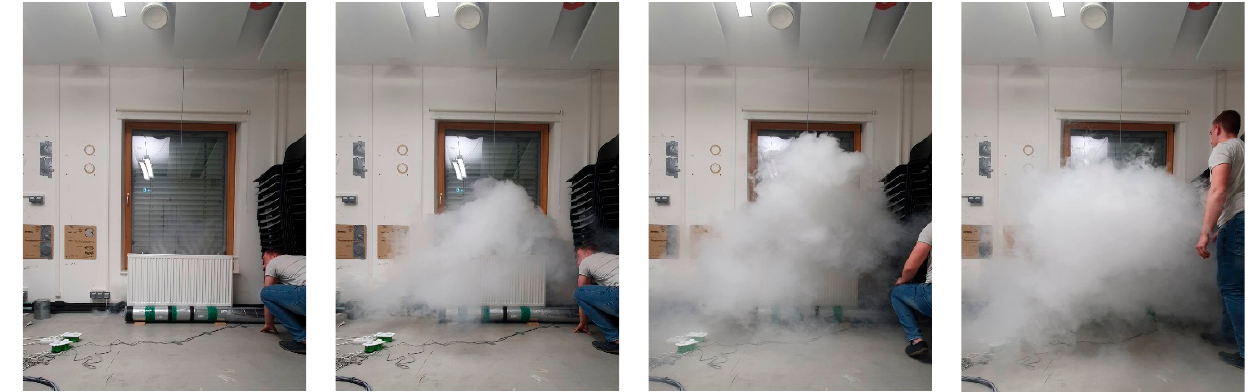
Figure 16. Air circulation pattern of radiators LOW. Periodic snapshots every 5 s.